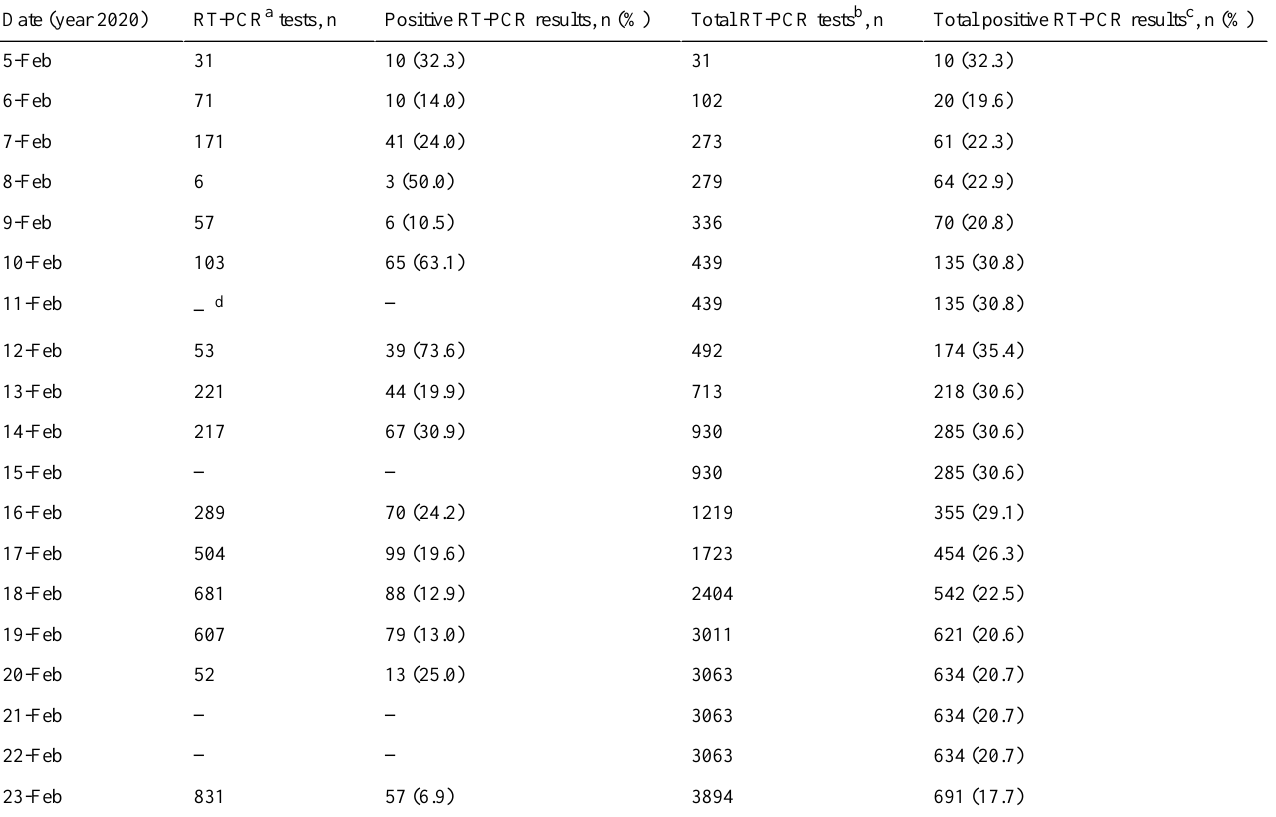
Table 1. Reverse transcription–polymerase chain reaction tests and the results.